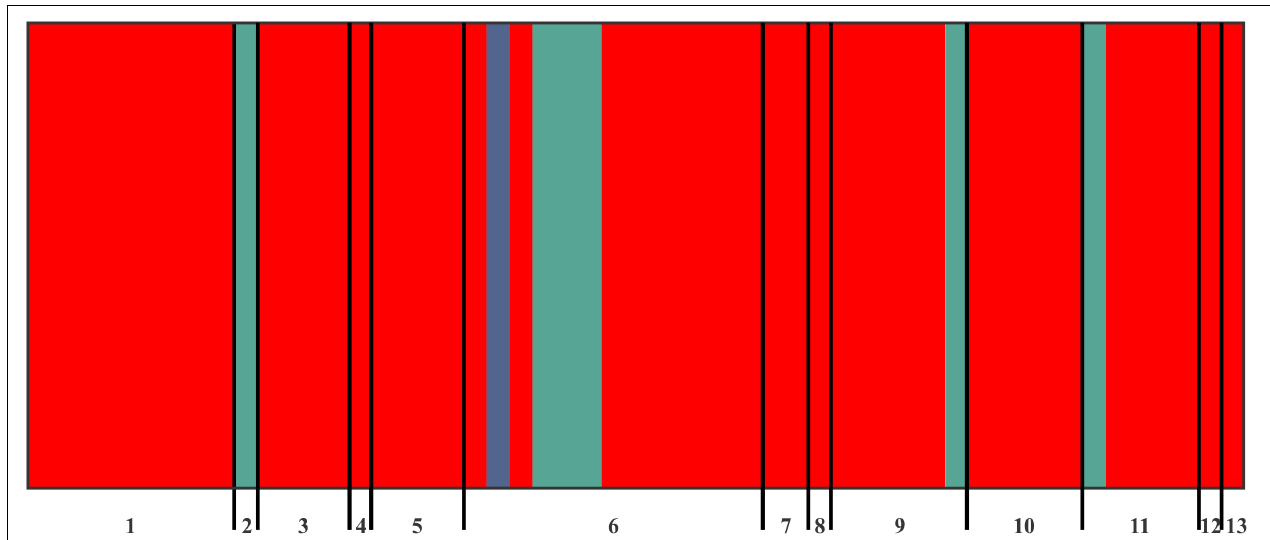
FIGURE 2 | Bayesian groupings (BAPS) for the concatenated ITS, β -tubulin, Eap1, and mitochondrial gene LAGLIDADG of S . reilianum individuals. Vertical lines indicate the posterior probability of each individual belonging to one of the three genetic clusters recovered in this study (red, blue, and green). 1, Árbol Grande Mixquiahuala (AGMX); 2, La Cañada (CAMX); 3, Cinta Larga (CILA); 4, Endo (ENDO); 5, Francisco I. Madero (FIMA); 6, Los Pinos Tezontepec (PITE); 7, Progreso (PROG); 8, Tetepango (TENA); 9, Teñhé Mixquiahuala (TNMX); 10, Tezontepec de Aldama (TZAL); 11, Tlahuelilpan (TLAH); 12, UPFIM (UFIM); 13,